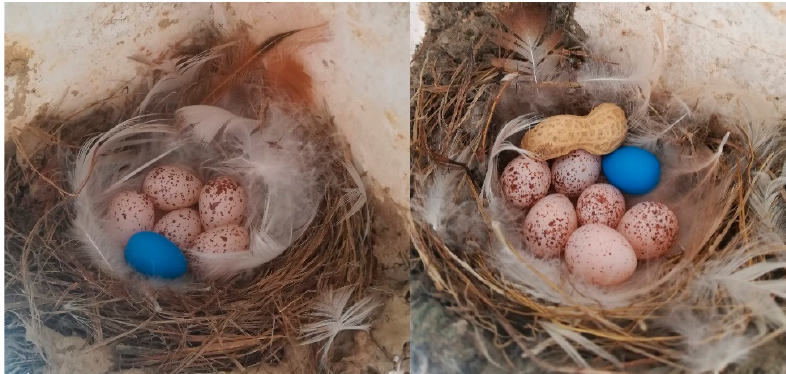
Figure 1. An example of mock trial (left) and mock + peanut trial (right) in this